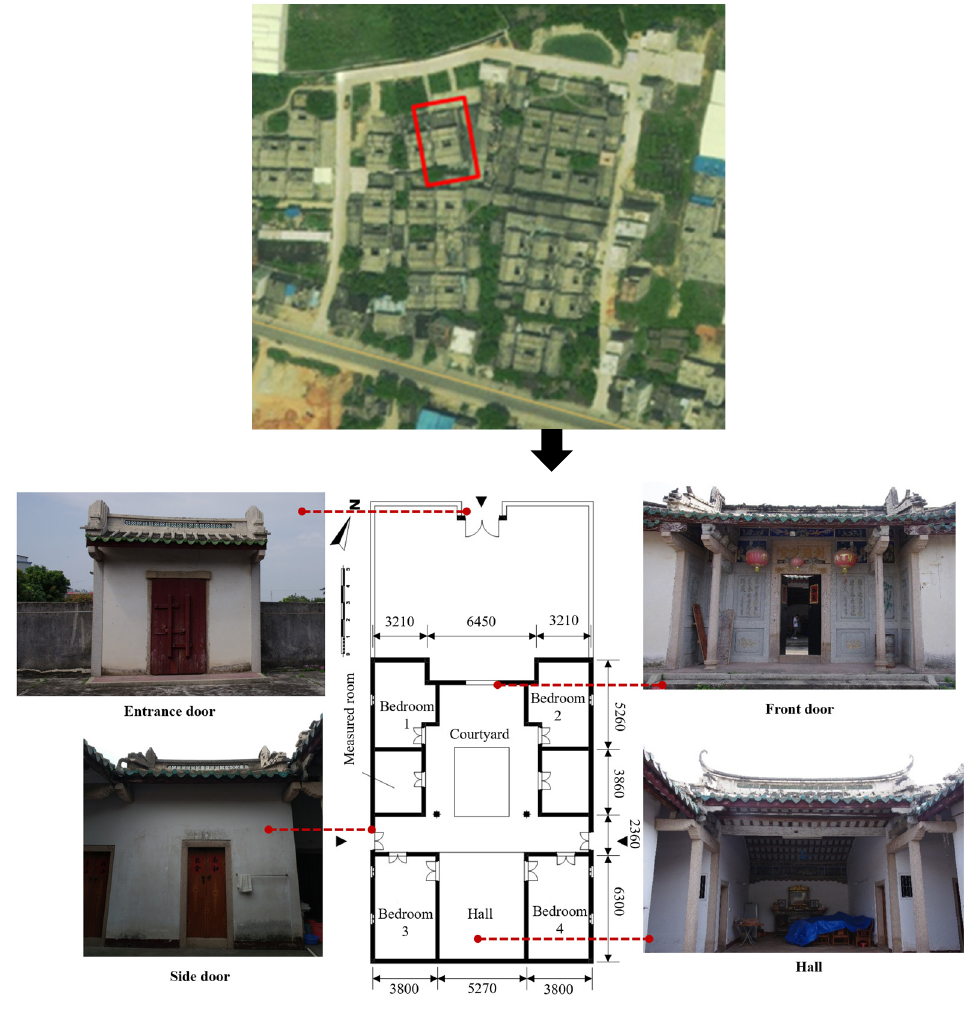
Figure 2. Location, status quo and the floor plan of the “Four-point gold” house.